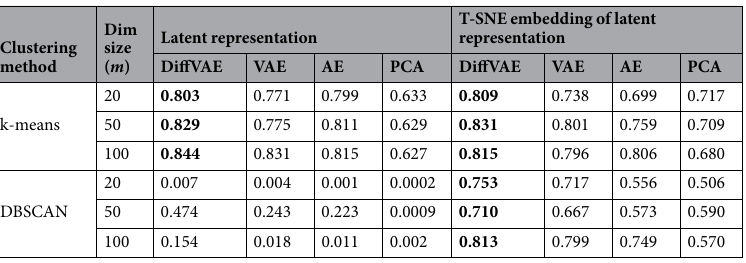
Table 2. Zebrafish. Mean ARI obtained for clustering the latent representation and the t-SNE embedding of the latent representation for three settings of the reduced dimension size m . The clustering algorithms used are k - means and Gaussian Mixture